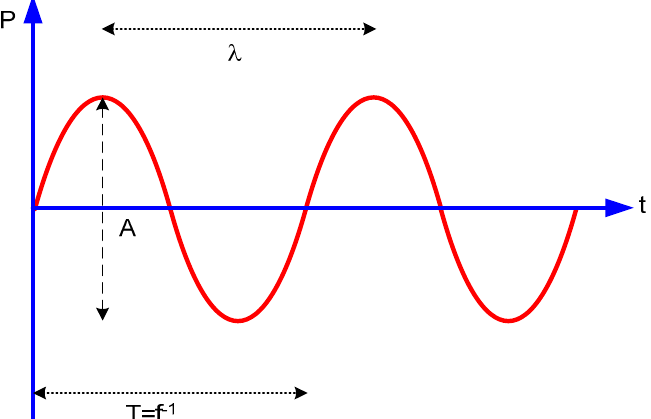
Figure 1. Acoustic wave parameters. P is the pressure wave (Pascal). A is the amplitude; the highest point of the wave is the crest, and the lowest is the valley. λ is the wavelength (meter), T is the period (second) and f is the frequency (Hertz).